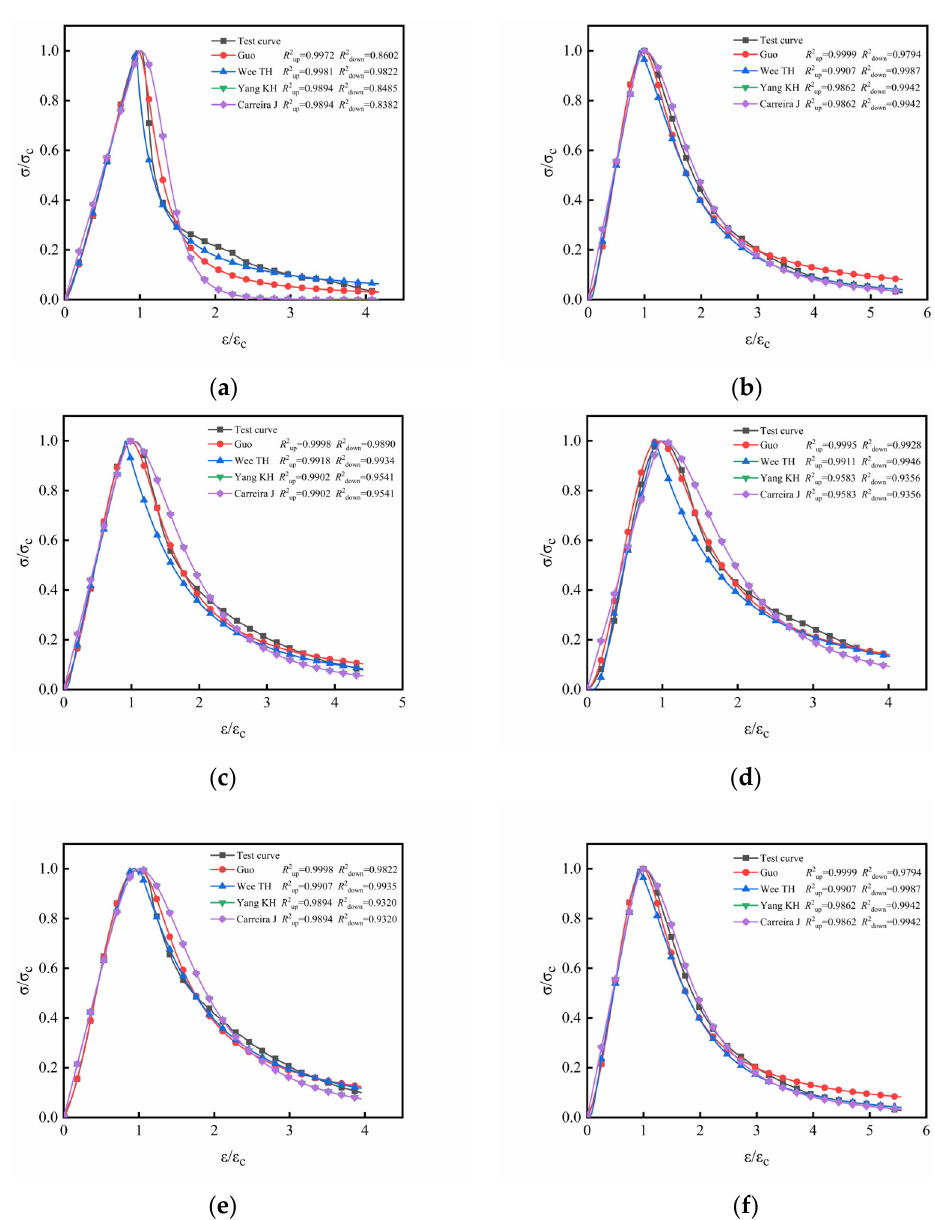
Figure 12. Comparison between existing constitutive models and experimental curves: ( a ) RC group; ( b ) BFC group; ( c ) PFC group; ( d ) BPRC 1 group; ( e ) BPRC 2 group; ( f ) BPRC3 group.